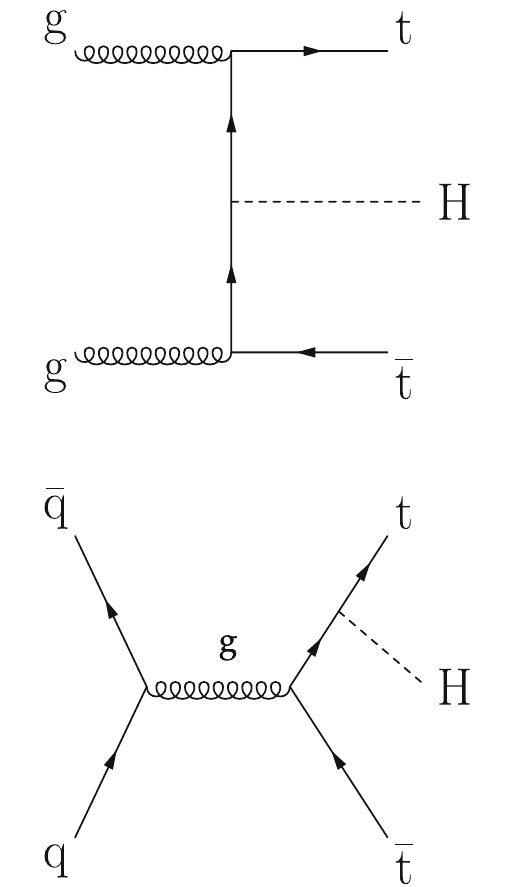
Fig. 1 Feynman diagrams at LO for ttH